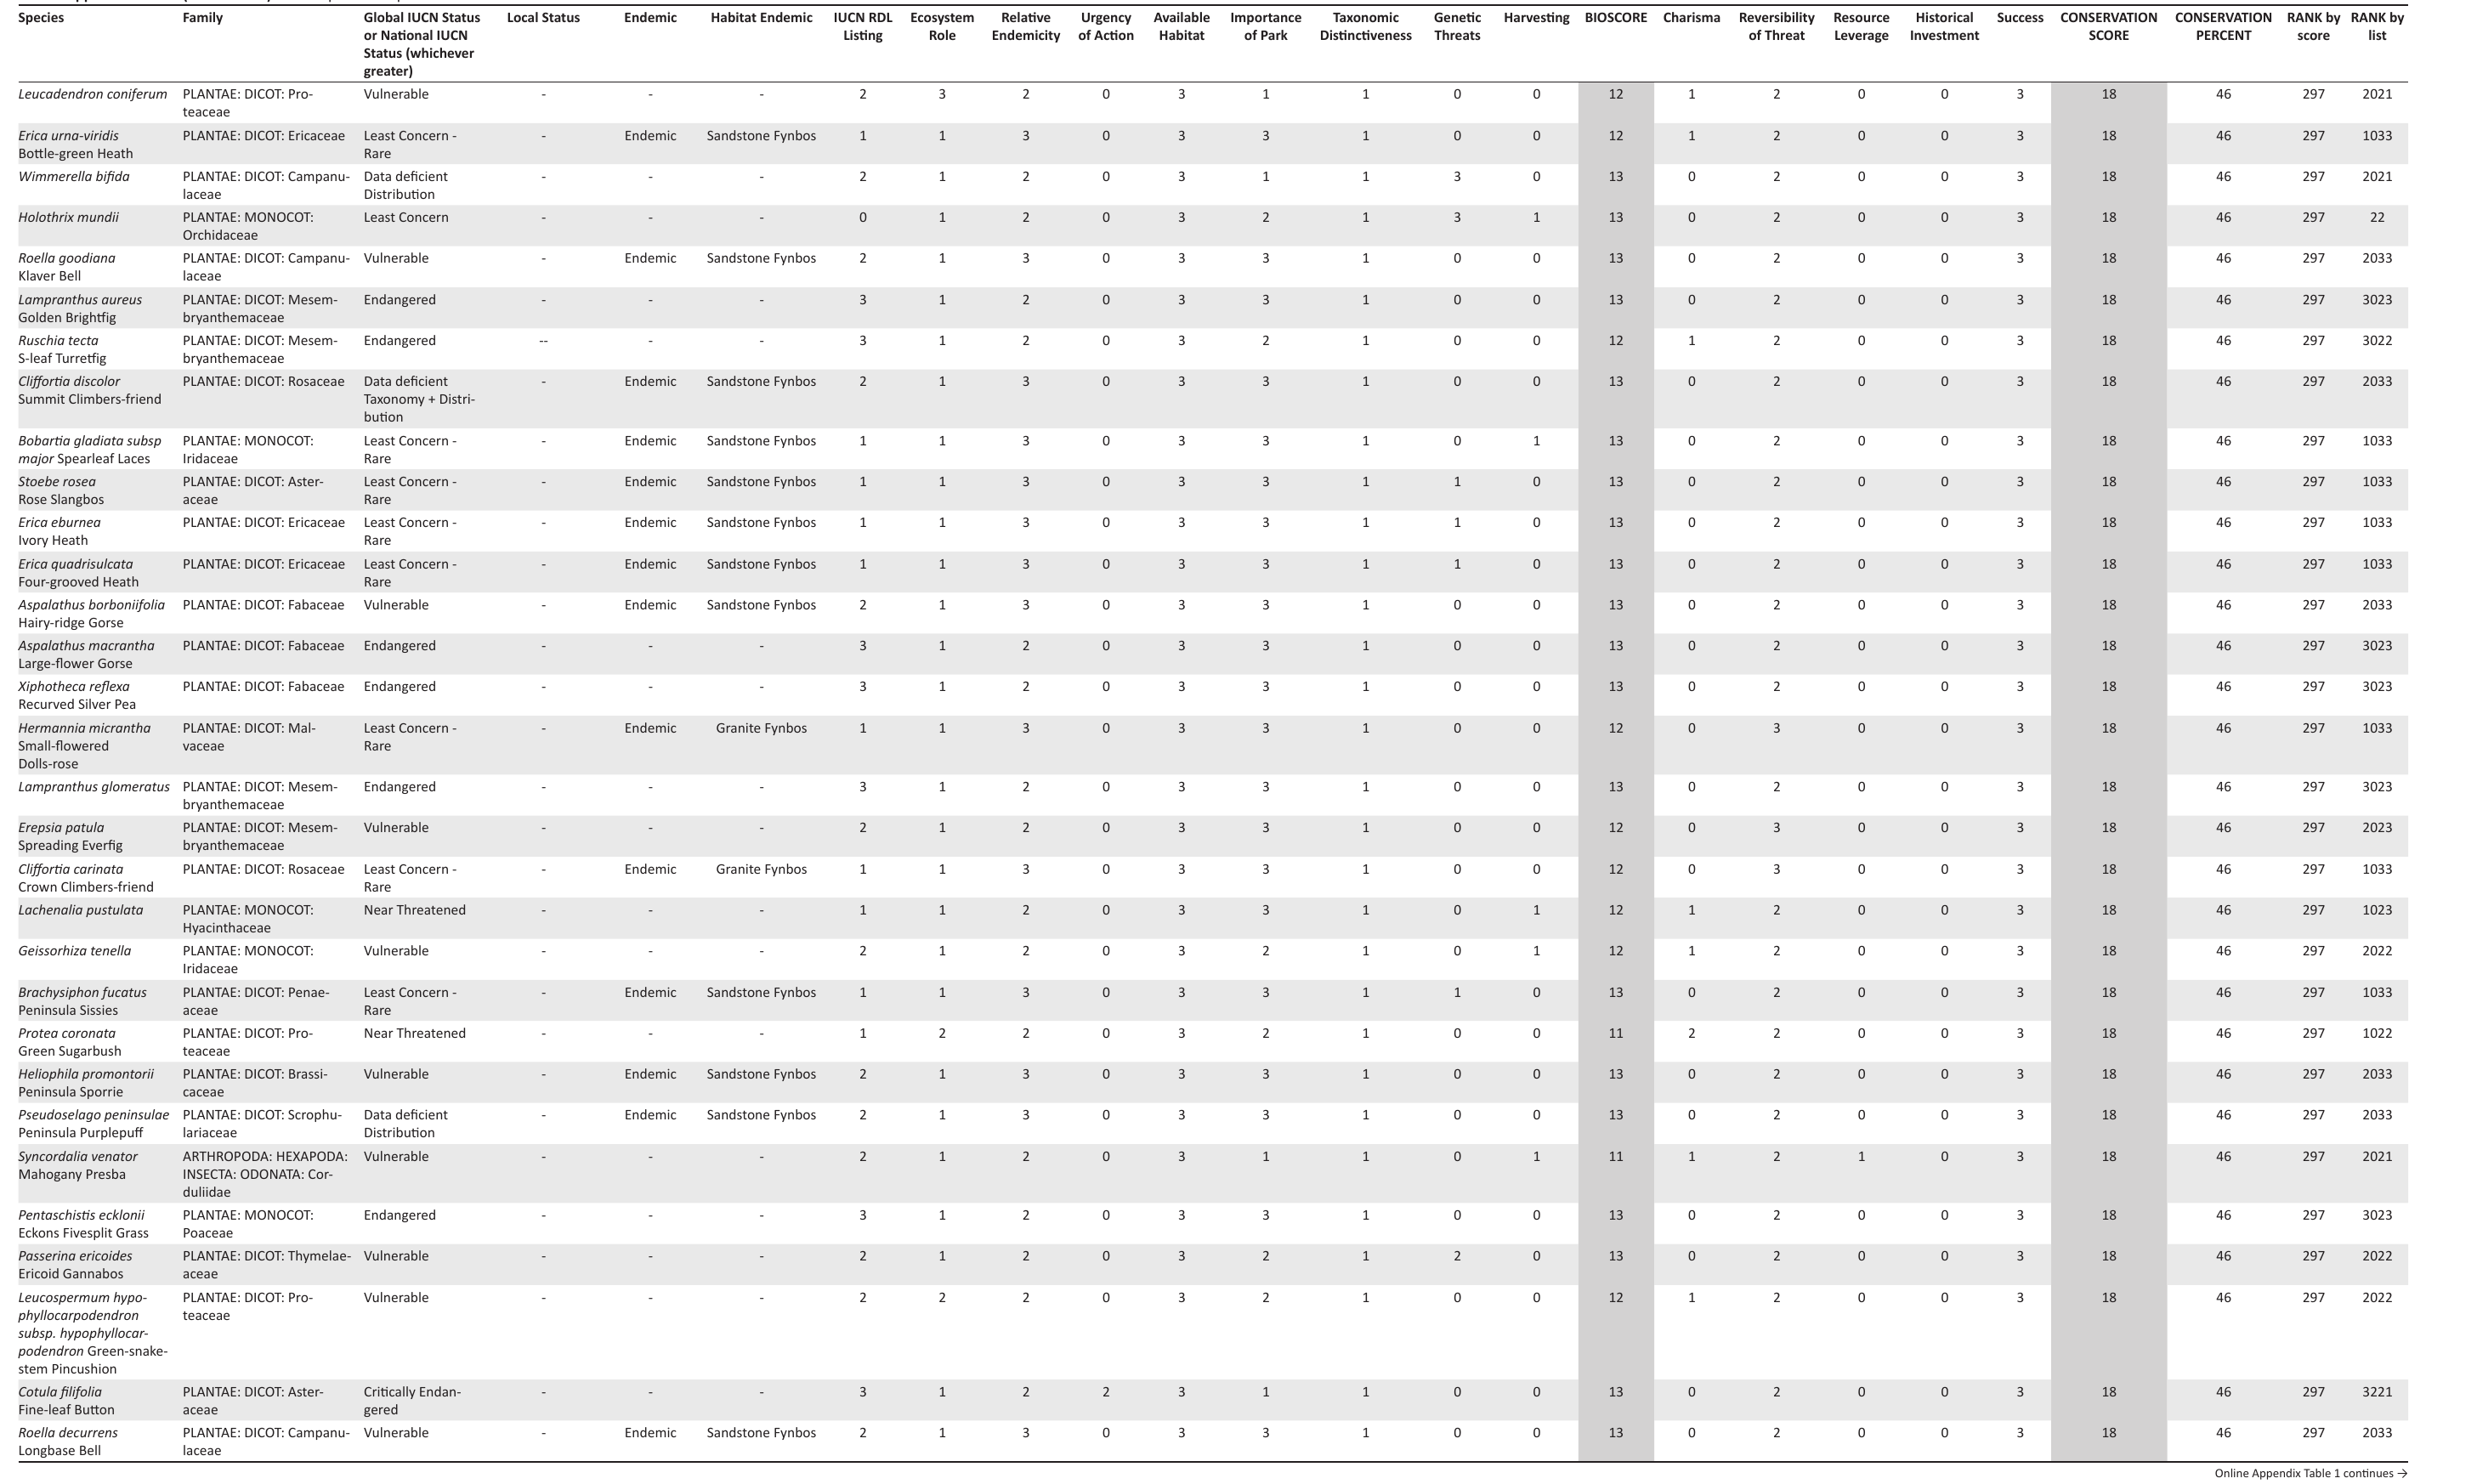
Online Appendix Table 1 (Continues...): List of species of Special Concern in the Table Mountain National Park and associated scores Species